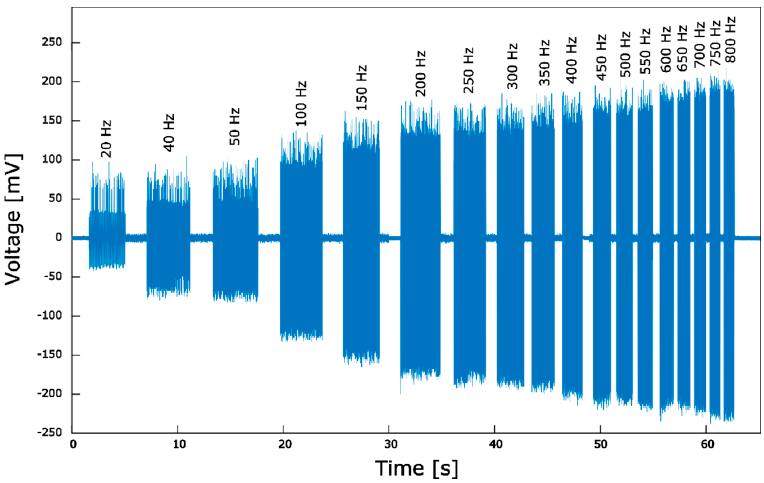
Figure 10. Sensor voltage response as function of the vibration frequency.